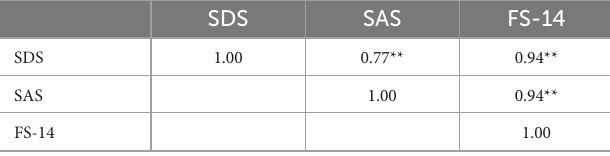
TABLE 3 Spearman correlation analysis of depression, anxiety, and fatigue score